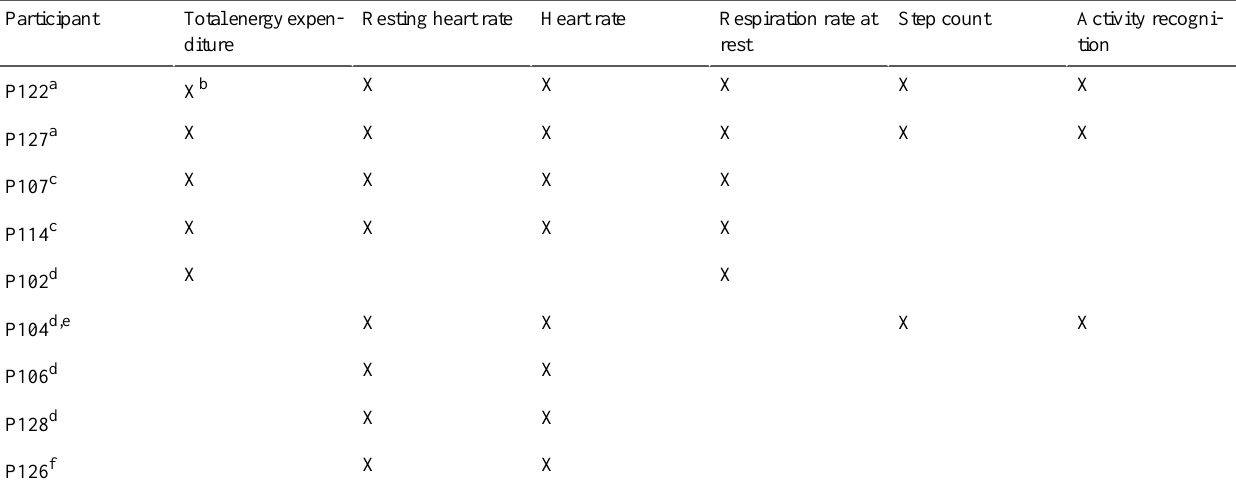
Table 2. Overview of participant data that were excluded entirely or partially from analysis.